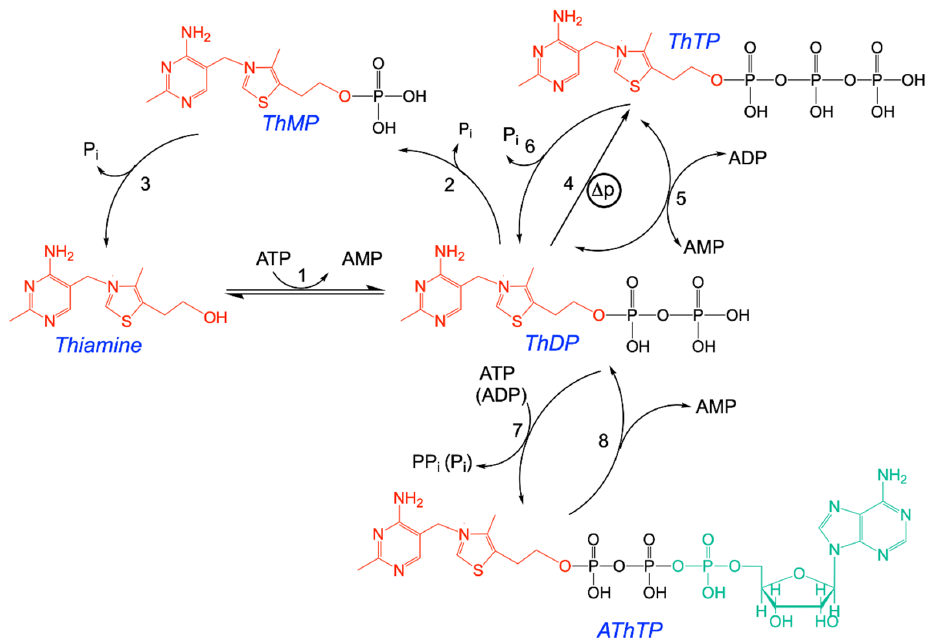
Figure 1. Structural formulas of thiamine and its major derivatives . ThDP is synthesized from thia- mine and ATP by thiamine pyrophosphokinase (1). Hydrolysis of ThDP by thiamine pyrophospha- tases (2) yields ThMP, which in turn can be hydrolyzed to thiamine by thiamine monophosphatases (3). ThDP can be phosphorylated to ThTP by two mechanisms: mitochondrial ATP synthase (4) and cytosolic adenylate kinase (5). ThTP can be hydrolyzed to ThDP by a very specific cytosolic 25-kDa thiamine triphosphatase (THTPA) but also by other hydrolases (6). ThDP can also be converted to AThTP by a ThDP adenylyl transferase (7). AThTP can be hydrolyzed to ThDP and AMP by a pu- tative AThTP hydrolase (8). Another adenylated thiamine derivative, adenosine thiamine diphos- phate (AThDP), not represented here, has been shown to exist in prokaryotes and eukaryotes, but its mechanism of synthesis has not yet been demonstrated in vitro. P i , inorganic phosphate; PP i , inorganic pyrophosphate; ∆ p, proton gradient (adapted from [18]).